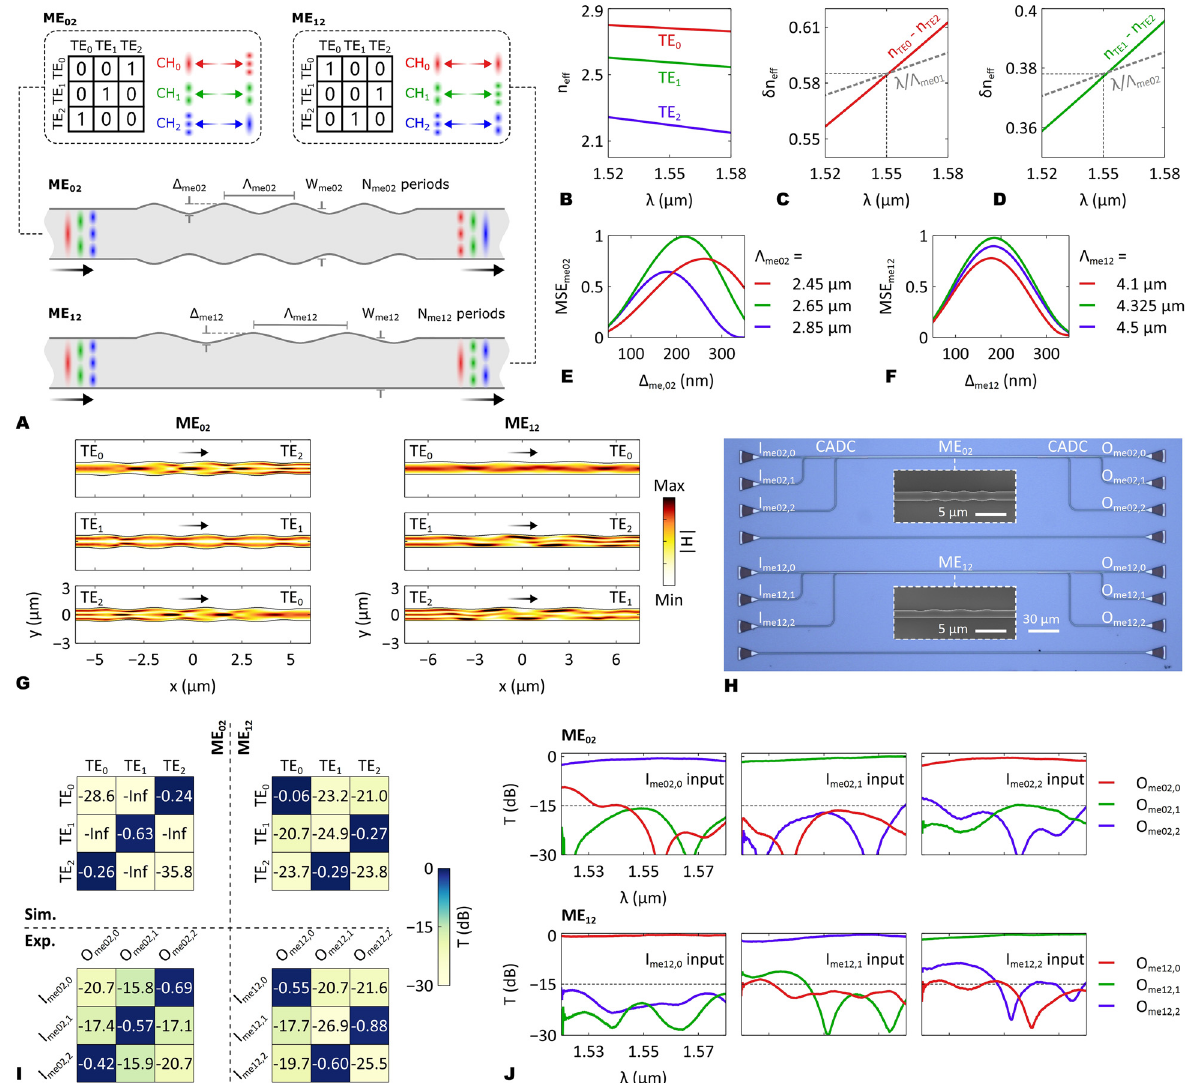
Figure 2: Design and results for mode exchangers (ME). (A)Theschematicconfigurationofmodeexchangers(ME 02 ,ME 12 )forTE 0 – TE 2 andTE 1 – TE 2 modeswap.Theinsetsshowmode-swapprocesses. (B)Thecalculatedeffective-index( n eff )dispersioncurvesofTE 0 – 2 modes.Theindex-mismatch( δ n eff )compensationsfor(C)ME 02 and(D)ME 12 . The calculated mode-swap ef fi ciencies (MSE me02 , MSE me12 ) for (E) ME 02 and (F) ME 12 with varied grating strengths ( Δ me02 , Δ me12 ) and grating pitches( Λ me02 , Λ me12 ).(G)Thecalculatedlightpropagationpro fi lesforME 02 (leftcolumn)andME 12 (rightcolumn)asTE 0 – 2 modesarelaunched. (H) The optical microscope image of fabricated devices with port identi fi ers labeled. The insets are scanning electron microscope (SEM) imagesofME 12 andME 02 .(I)Thecalculated(upperrow)andmeasured(lowerrow)transmittancematricesforME 02 (leftcolumn)andME 12 (right column) at the 1.55- μ m wavelength. (J) The measured transmittance spectra for ME 02 (upper row) and ME 12 (lower row). CADC, cascaded asymmetric directional